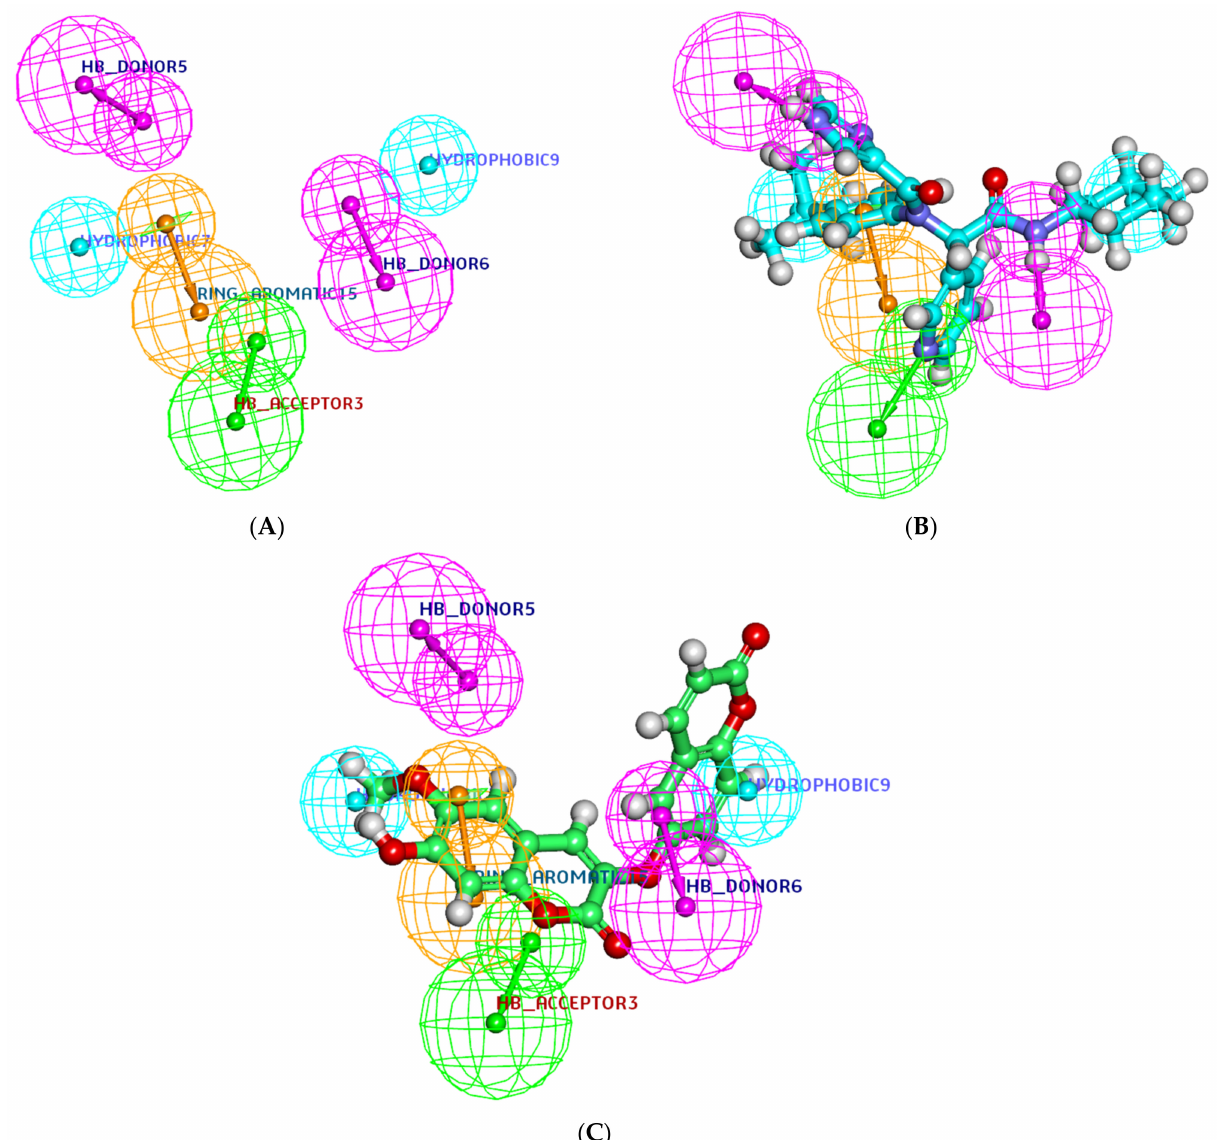
Figure 6. ( A ) The generated 3D-pharmacophore geometry with six features; two H-bond donors (pink), one H-bond acceptor (green), one ring aromatic (brown), and two hydrophobic centers (blue). ( B ) Mapping of the co-crystallized ligand ( X77 ) on the generated pharmacophore (fit value = 2.08). ( C ) Mapping of the jusan coumarin on the generated pharmacophore (fit value =